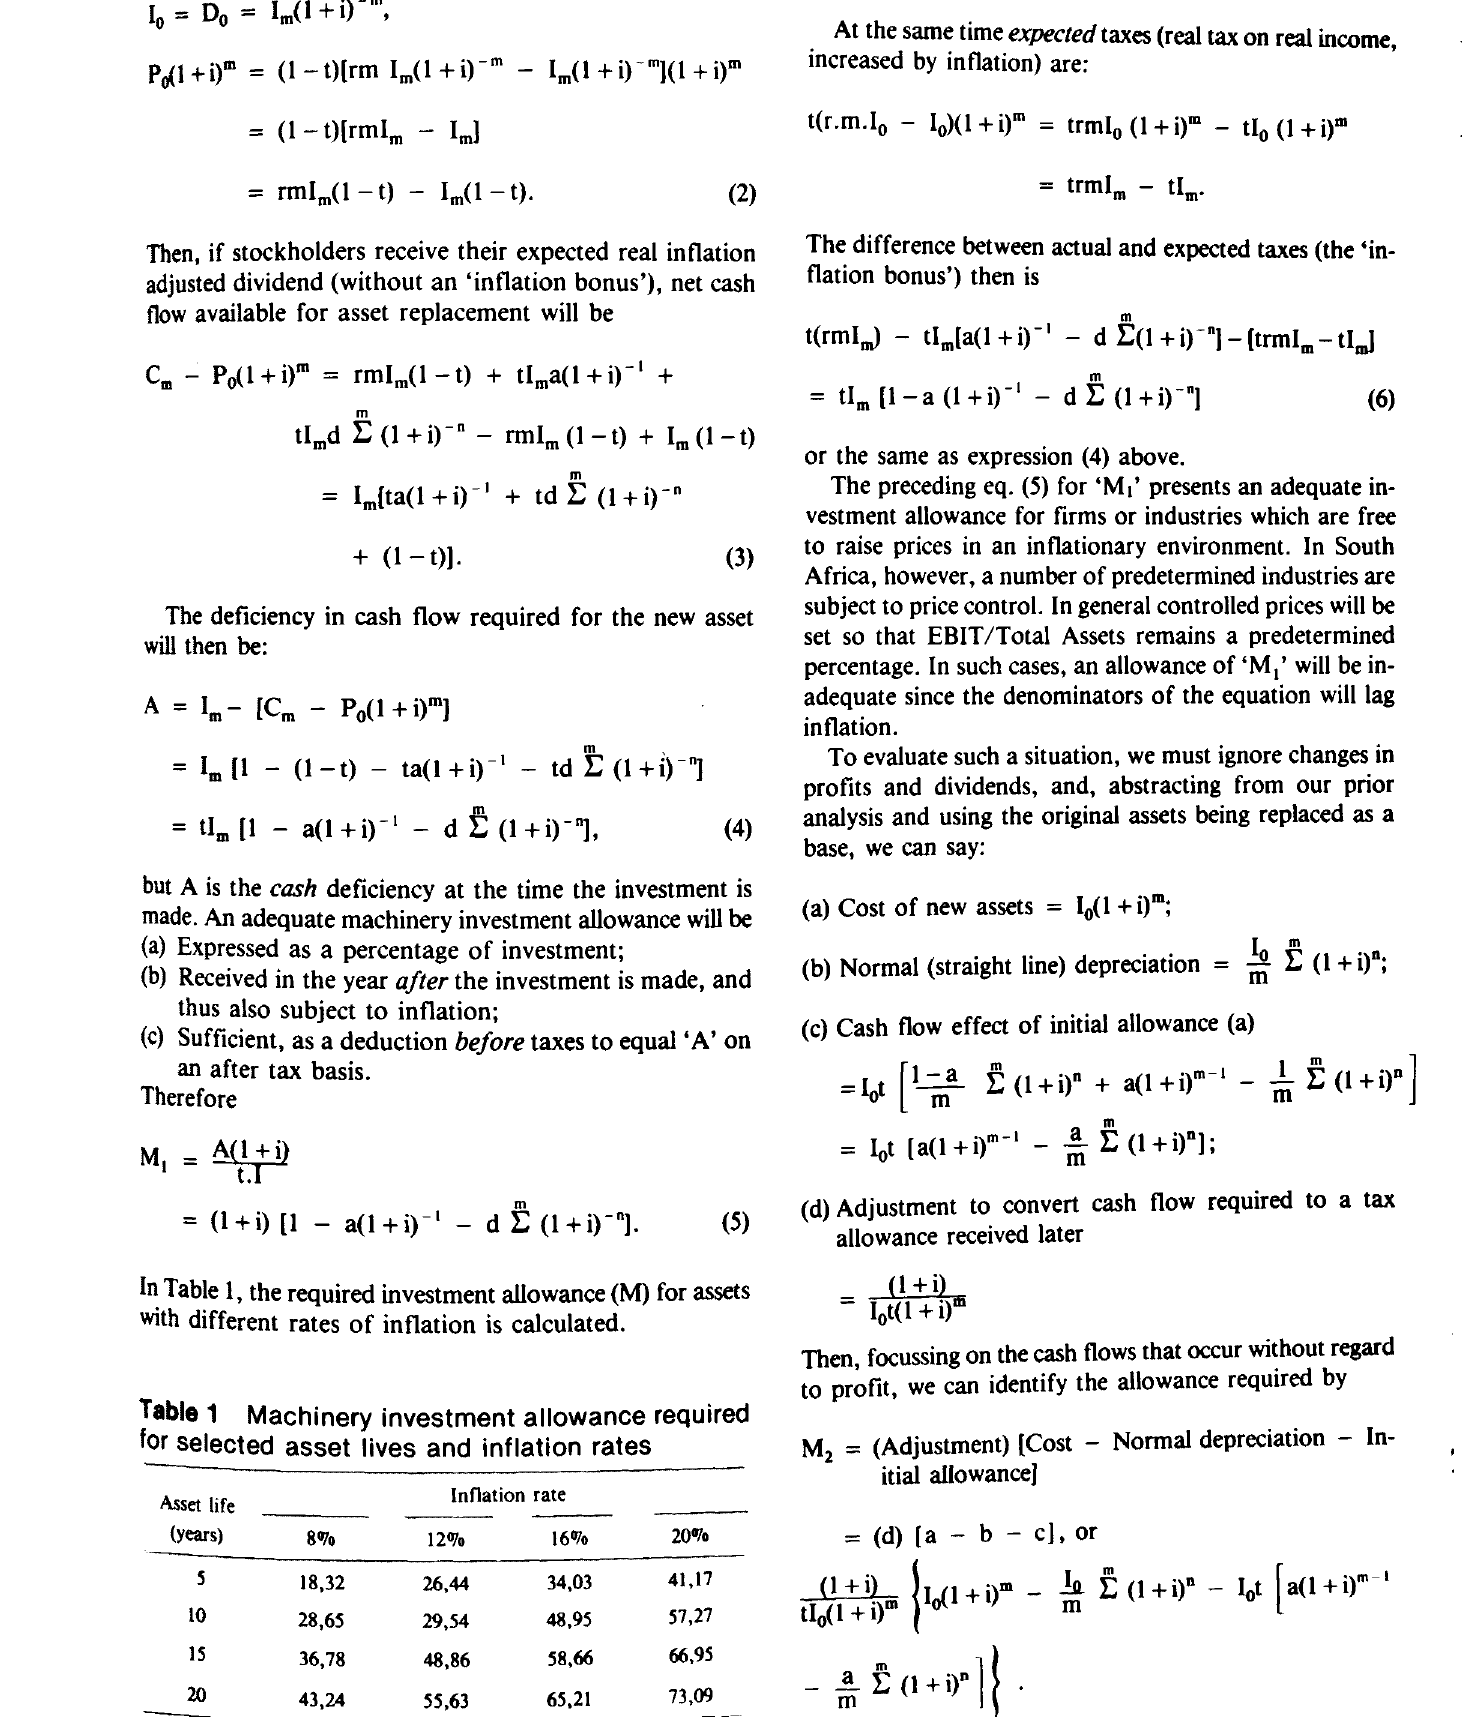
Tabla 1 Machinery investment allowance required for selected asset lives and inf latlon rates Asset